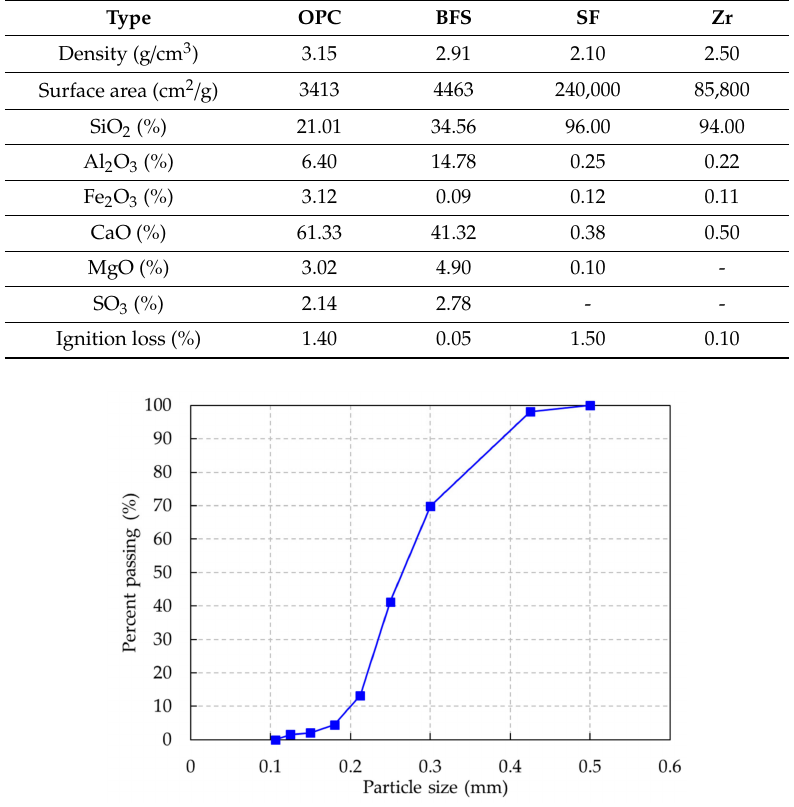
Figure 1. Particle size distribution of fine